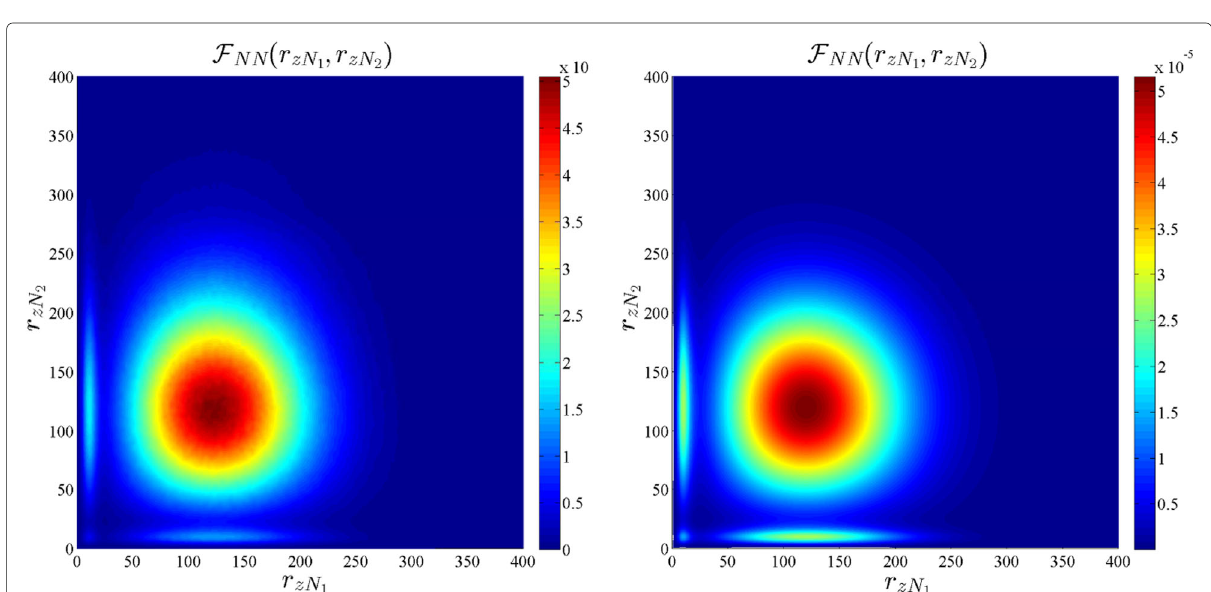
P c ((cid:12)) = A L P c , L ((cid:12)) + A N P c , N ((cid:12)) , (9)